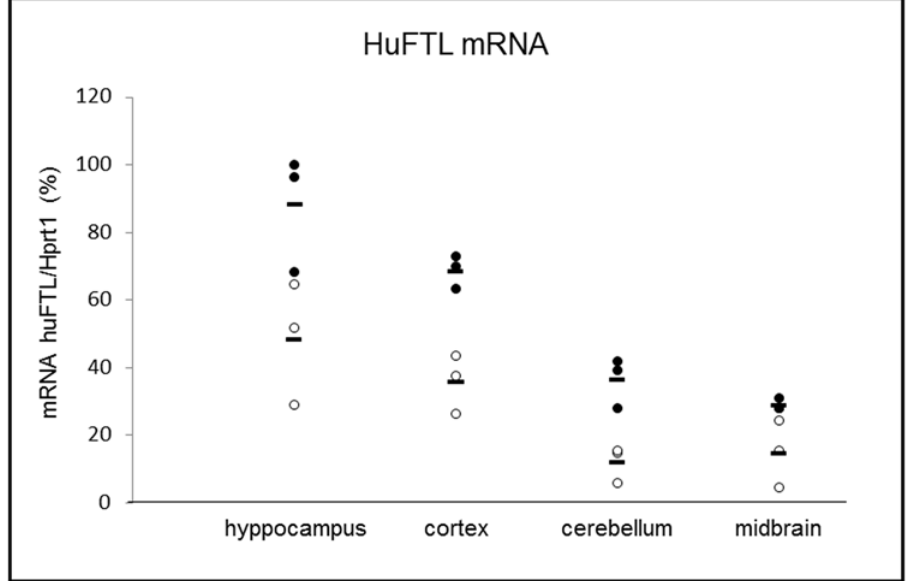
Fig 1. Evaluation of exogenous human FTL mRNA in the indicated areas of the brain of 8 month-old Tg-mice. Solid circles for males and the empty ones for females. The horizontal lines are the means. Data obtained by quantitative reverse-transcription polymerase chain reaction (qRT-PCR). The transcript of the transgene was higher in males than females, and higher in the hippocampus > cortex > cerebellum >